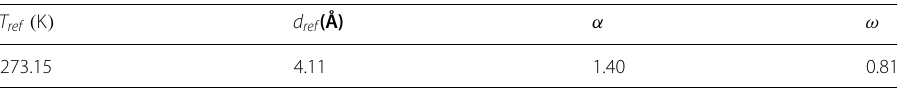
Table 1 VSS parameters of argon [17] T ref ( K ) d ref (Å) α ω